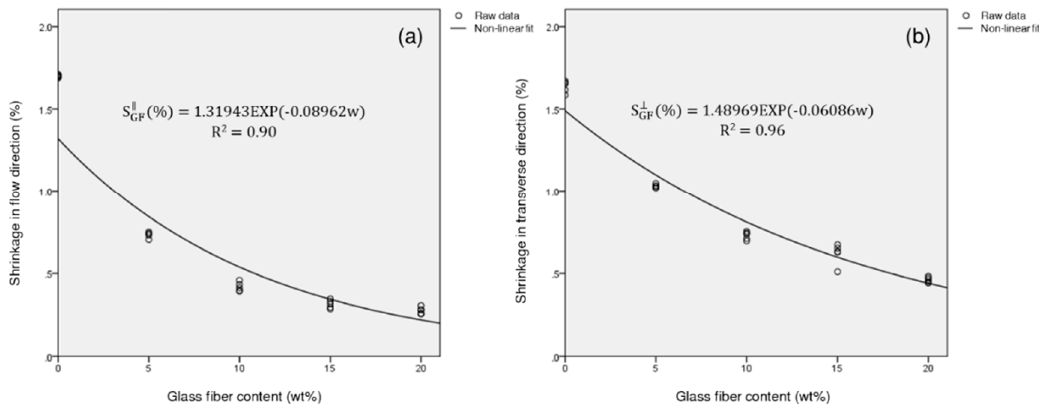
Figure 18. Regression analysis plot for the shrinkage of PP/T: ( a ) Shrinkage in the flow direction, and ( b ) shrinkage in the transverse direction.